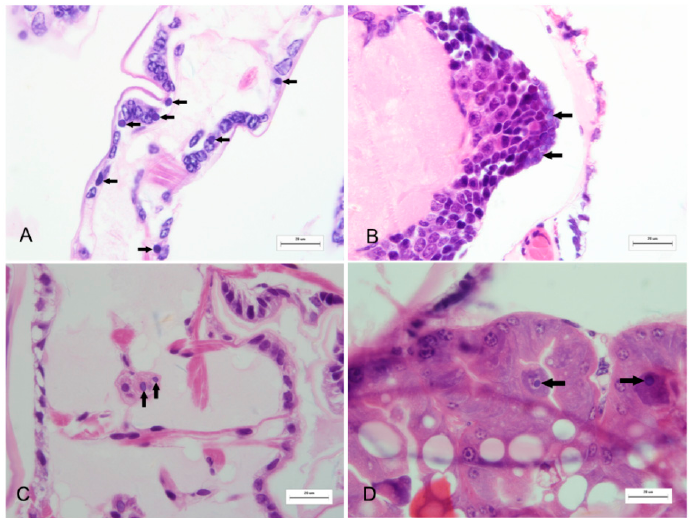
Figure 1. Illustration of viral inclusion bodies in the histological sections of diseased M. rosenbergii larvae. Pale to dark basophilic, intracytoplasmic inclusion bodies with 2.8 to 4.0 μ m in diameter are observed in a number of cells (indicated by arrows) in appendage epithelial tissues ( A ); ganglion ( B ); connective tissue ( C ); and hepatopancreas ( D ). All H and E. Bars = 20 μ m.